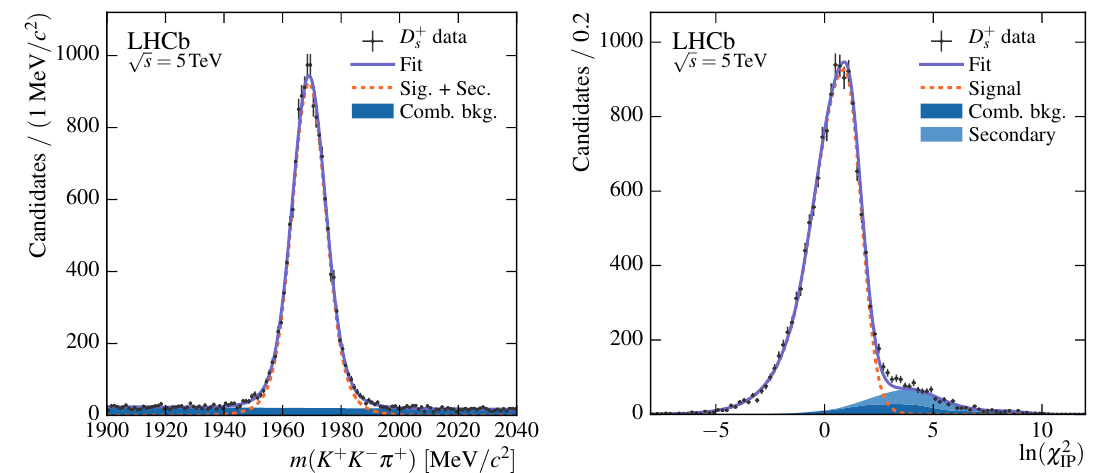
Figure 3. Distributions for selected D + ( K (cid:0) K + ) (cid:30) (cid:25) + candidates: (left) K + K (cid:0) (cid:25) + invariant s ! (cid:0) (cid:1) mass and (right) ln (cid:31) 2 for a mass window of 20 MeV = c 2 around the nominal D + IP (cid:6) sum of the simultaneous likelihood (cid:12)ts in each ( p T ; y ) bin is shown, with components as indicated in the legends.